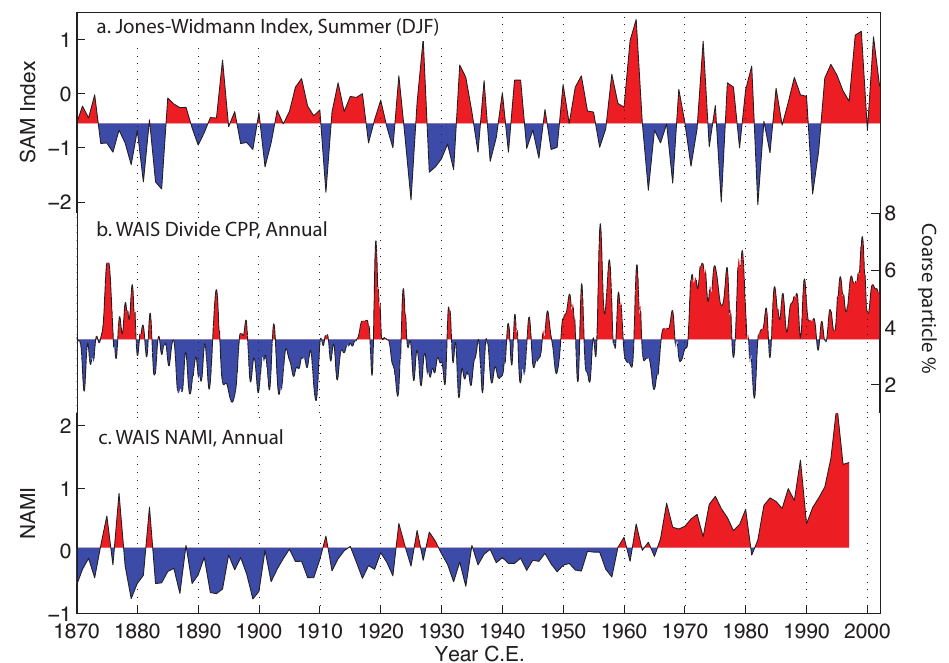
Figure 7. Comparison of Southern Annular Mode (SAM) index and West Antarctic circulation proxies for the period 1870–2002CE: (a) Jones-Widmann Index (JWconcat), based on the first principal component of extratropical SLP, using both ERA-40 climate reanaly- sis data and station measurements (Jones et al., 2009). (c) WAIS Divide coarse particle percentage (this work). (e) Proxy for “northerly air mass incursions” (NAMI) into West Antarctica, based on stacked nssCa concentration data from 10 ice cores (Dixon et al., 2012). The red/blue delineation for each curve is the mean of that record over the time interval